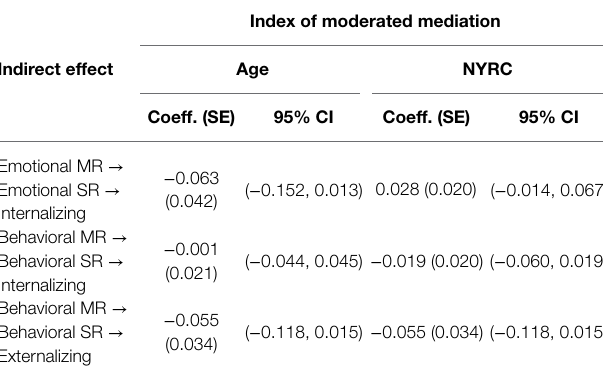
TABLE 4 | Moderated mediation